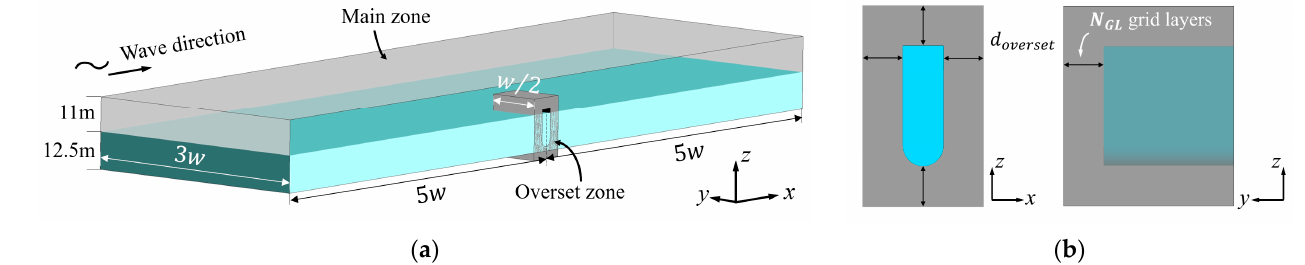
Figure 4. CFD computational domain: ( a ) an overall diagram of NWT with a symmetry xz plane bisecting the tank; ( b ) the overset zone with N GL grid layers between the external cubic surface and the flap surface (in blue).